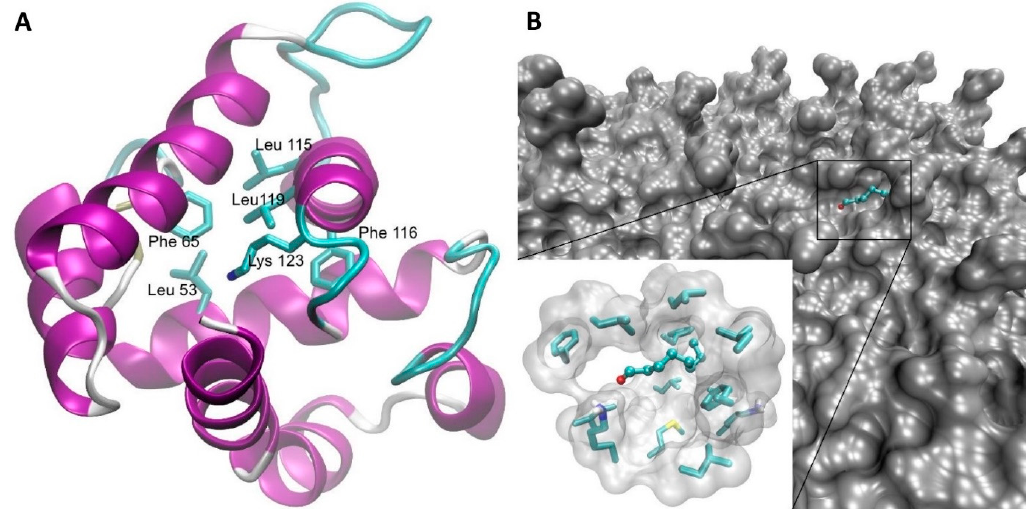
Figure 1. ( A ) Three-dimensional model of HarmOBP7. The model was built on the crystal structure of OBP1 of a pheromone-binding protein from Bombyx mori (PDBID: 1dqe). Sidechains of amino acids forming the hydrophobic binding site responsible for interaction with the long nonpolar chain of odorants as well as Lys123 participating in the Schiff base formation are shown as sticks models. ( B ) Example of octanal bound to the model of OBPP3 receptor. The ligand (octanal) is shown as a balls and sticks model, while sidechains of nonpolar amino acids (Leu8, Leu1, Leu5, Phe2, Met12) forming a hydrophobic pocket, as well as the sidechain of Lys11 putatively responsible for the Schiff base formation, are depicted as regular sticks models.